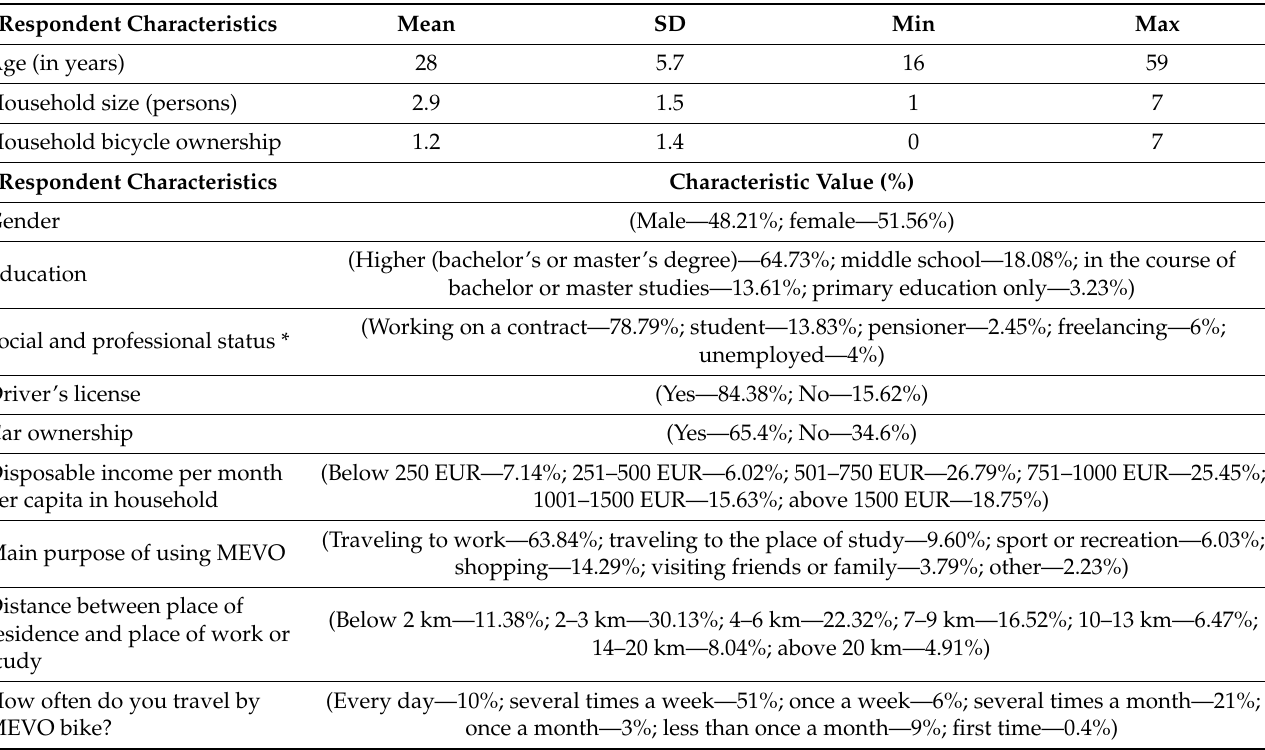
Table 1. Characteristics of the survey sample ( n =